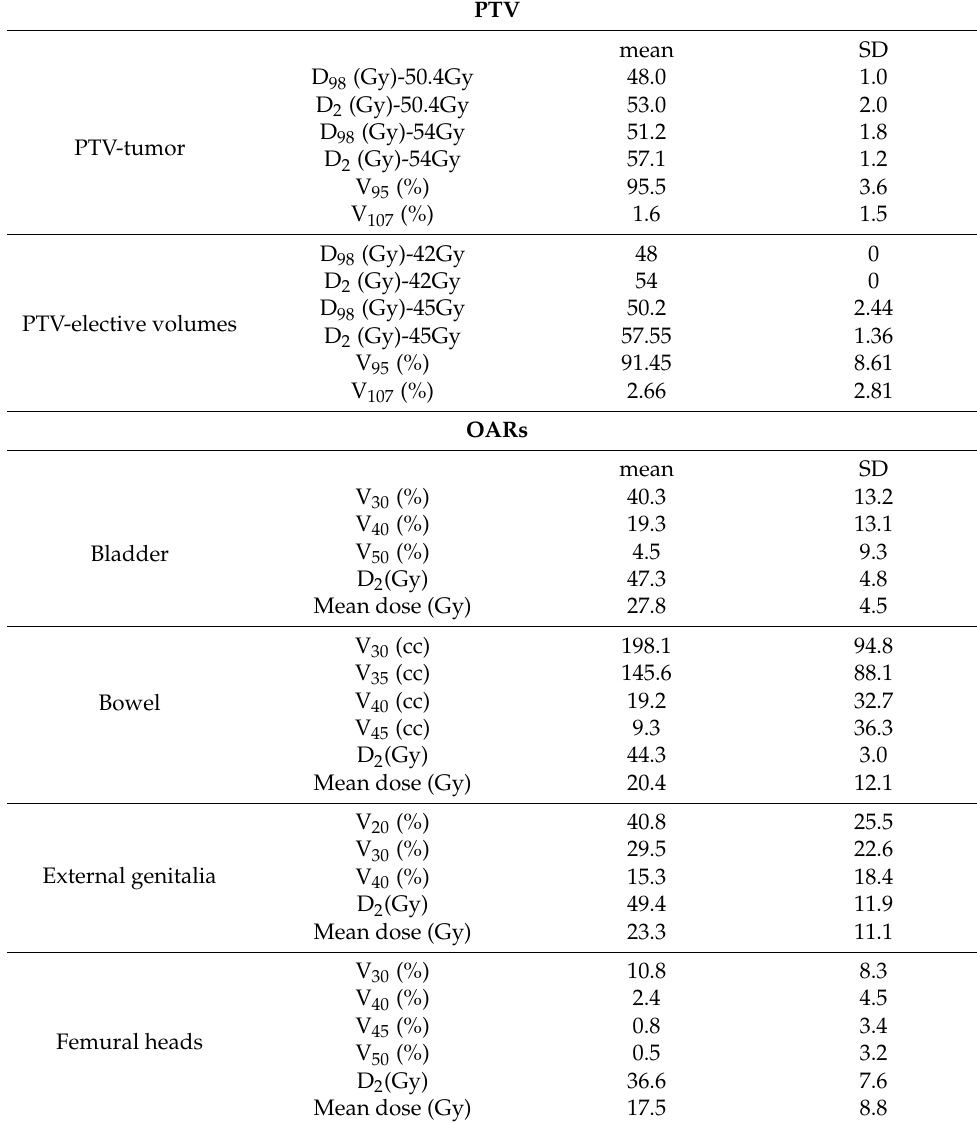
Table 4. Dosimetric parameters for both target and organs at